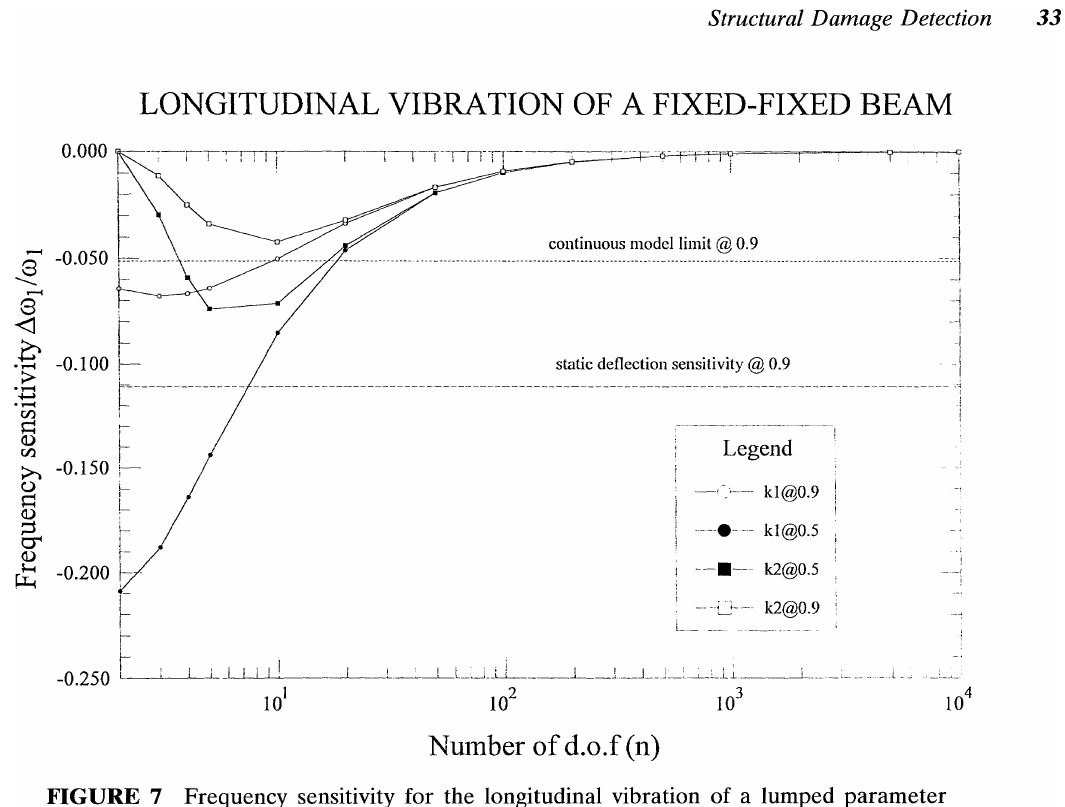
FIGURE 7 Frequency sensitivity for the longitudinal vibration of a lumped parameter fixed-fixed beam for various damage ratios and damaged springs, and extended in the limit toward the continuous model.